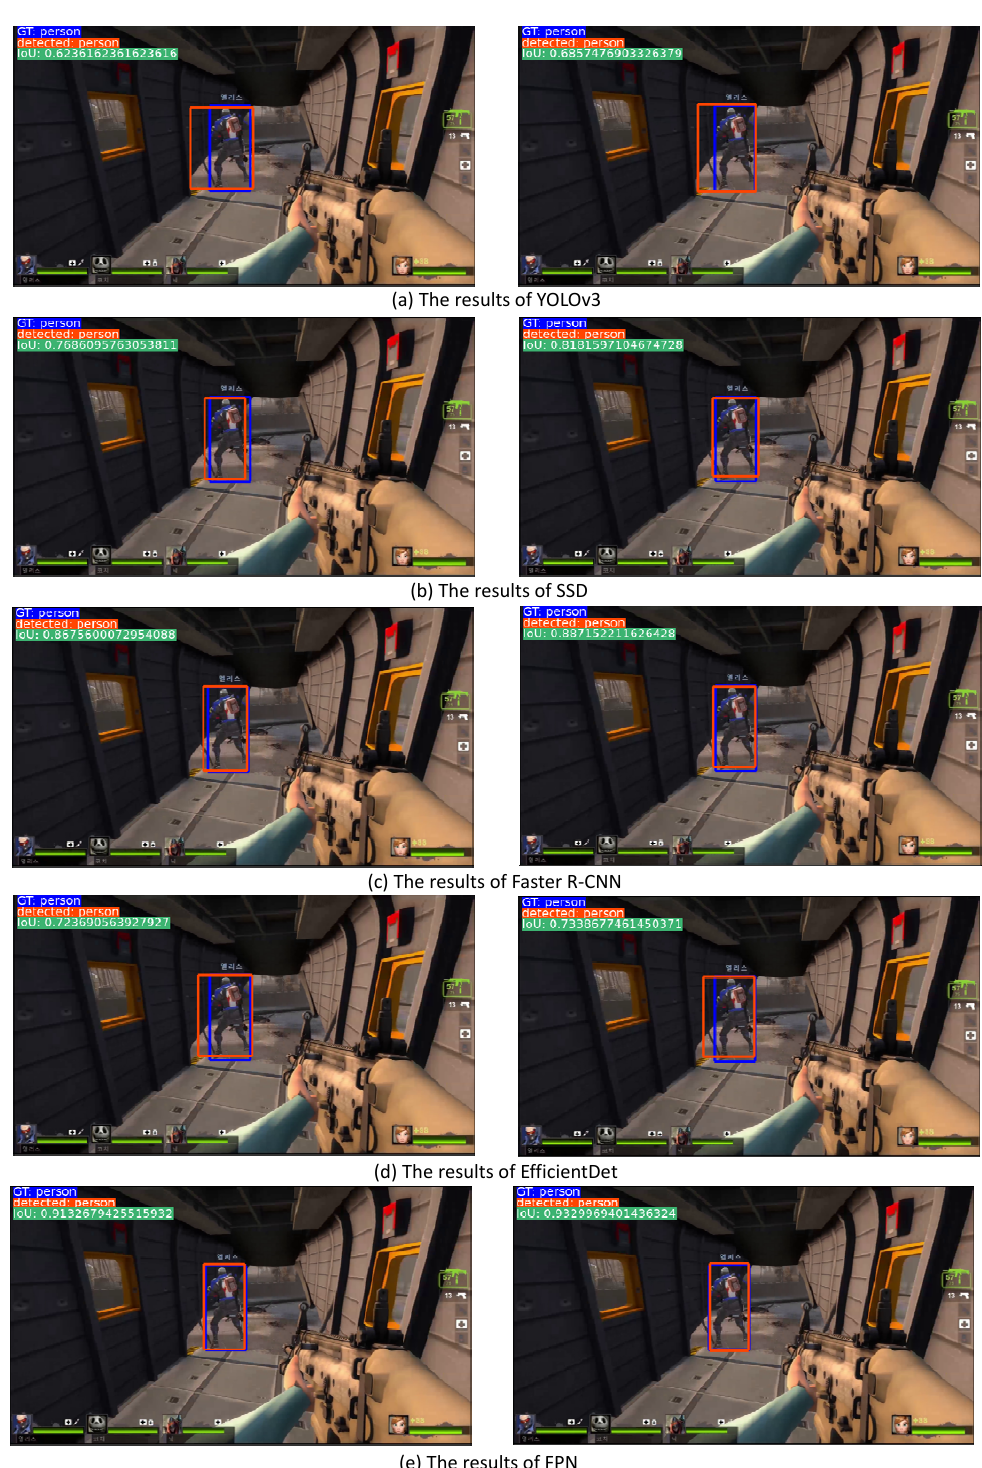
Figure A7. Comparison of the bounding box detection on game Left 4 Dead 2. The left column is the result from the models trained by PASCAL VOC and the right column is the result from the models trained by PASCAL VOC and game